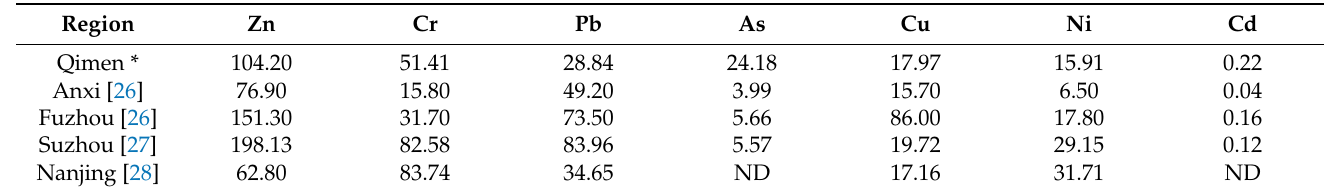
Table 4. Heavy metal concentrations (mg · kg − 1 ) in soil from An-tea plantations in the present study and from plantations in other areas from previous